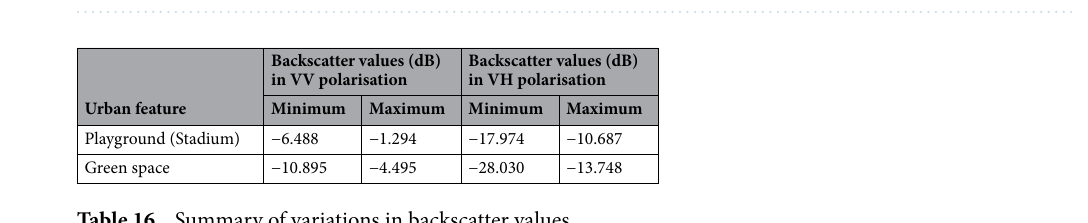
Figure 28. Colour composite image of the Sentinel-1 C-band data, dual-polarization data, and Google Image for site a & b .